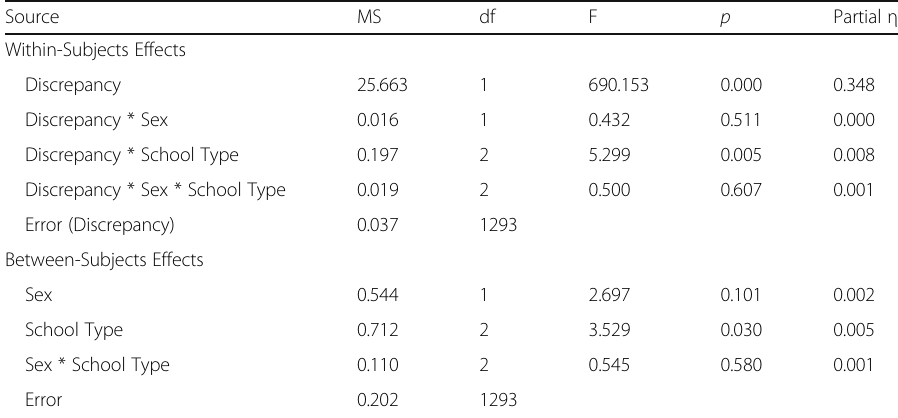
Table 6 Repeated measures ANOVA results for direct teaching ( N = 1299)